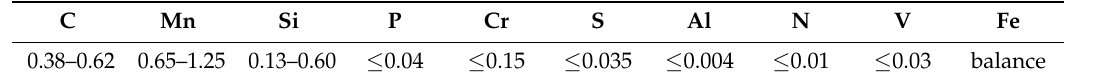
Table 2. The chemical composition of R200 steel (weight percentage, %).